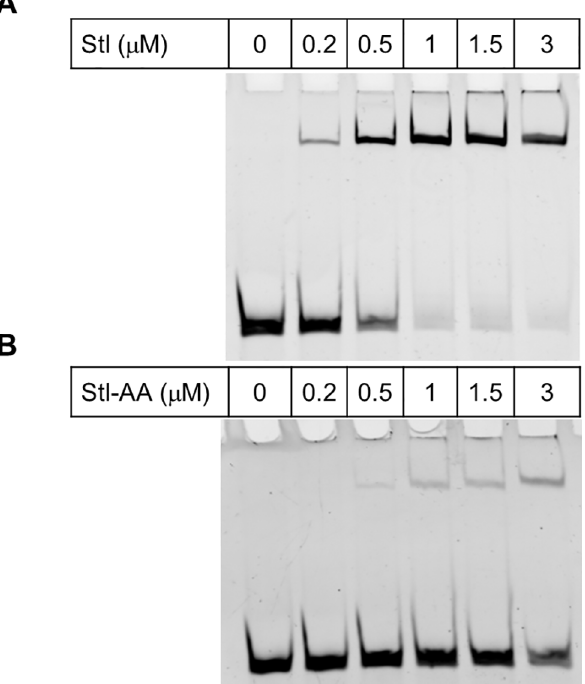
Fig 4. Electrophoretic mobility shift assay (EMSA) for testing the DNA binding ability of Stl constructs. (A) Result of EMSA with the wild type Stl protein. Note that the DNA band is shifted upwards at 1 μ M Stl concentration. (B) EMSA gel result of Stl-AA mutant protein. Note that even at relatively high (ie. 3 μ M) concentration of the Stl-AA mutant construct, most DNA still appears at the lower position on the gel, indicating lack of binding to the mutant